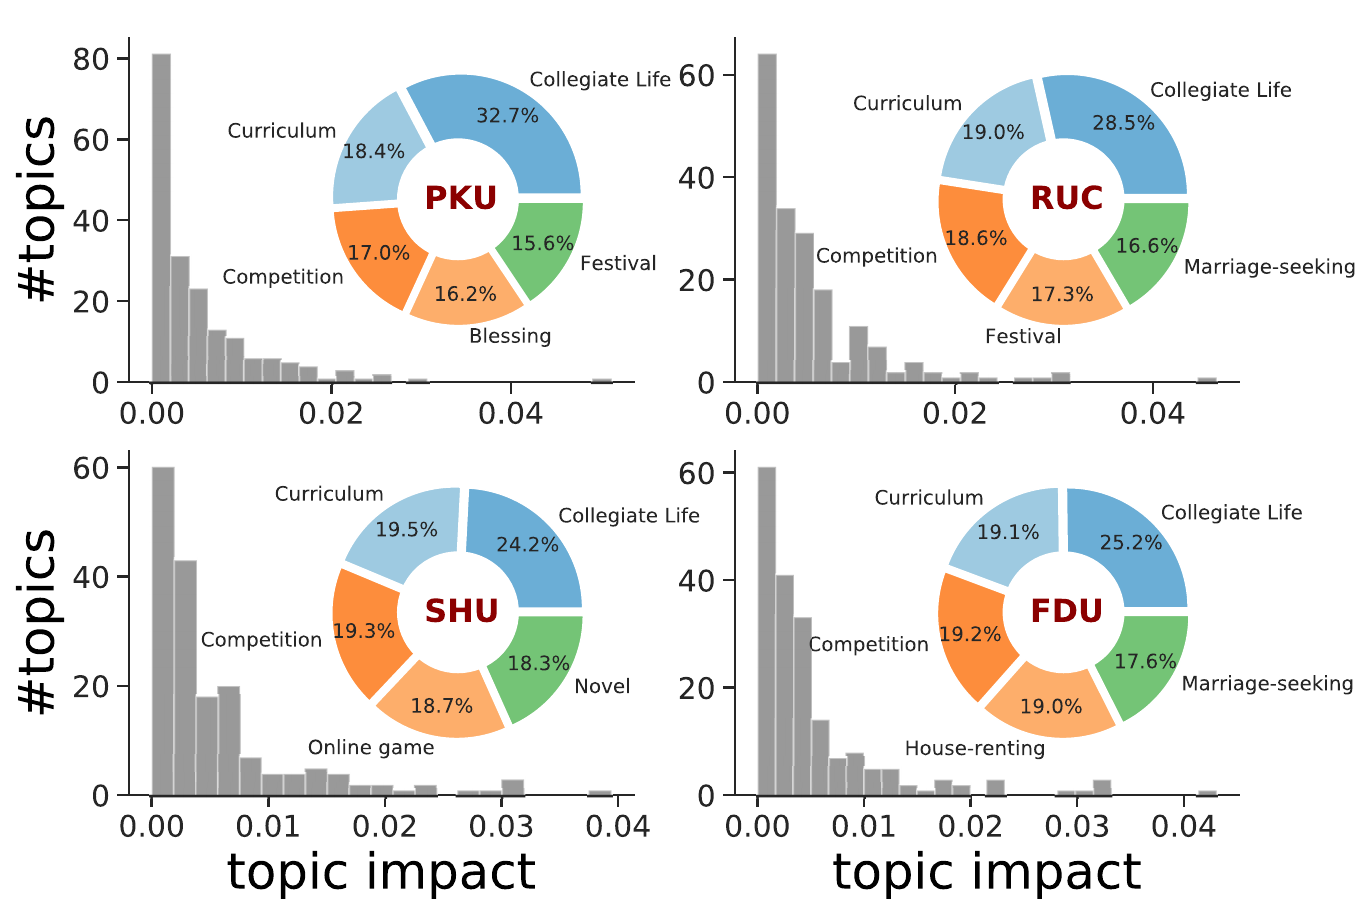
Fig 4. Frequency histograms of topics for four universities around 2006-2012. Each pie chart represents top 5 popular topics in that university with relative impact ratios.